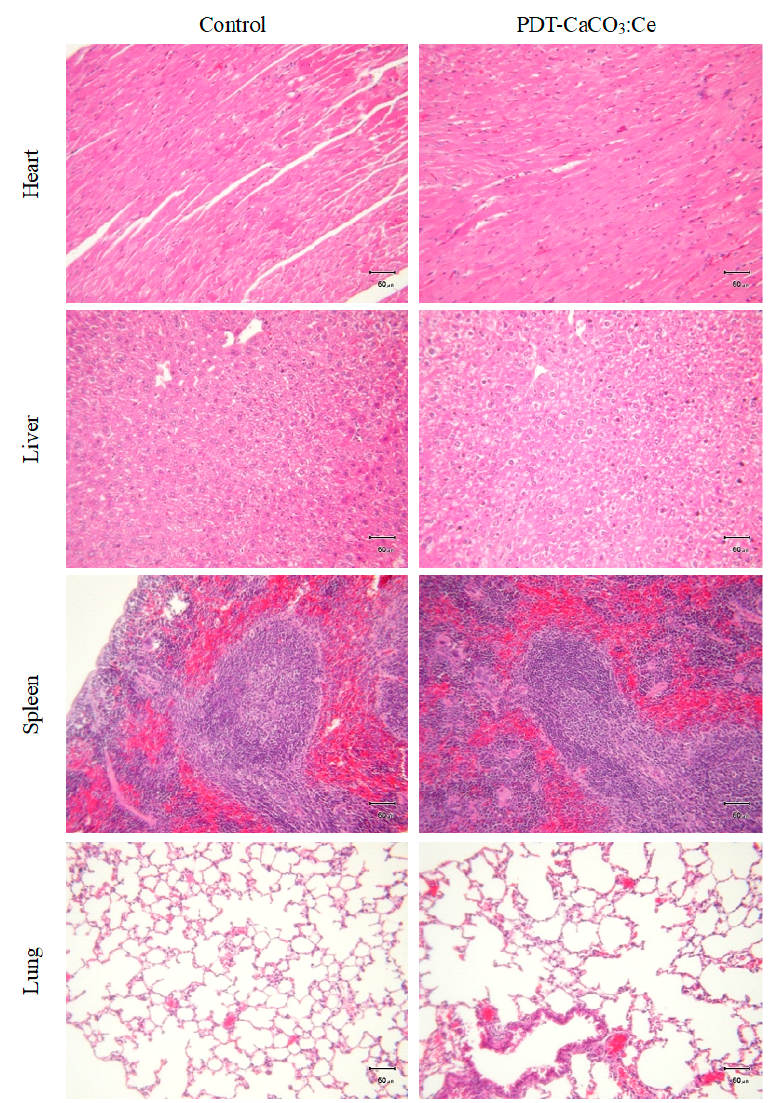
Figure 9. H&E-stained slices of major organs harvested from scarified BALB/c nude mice at the end of